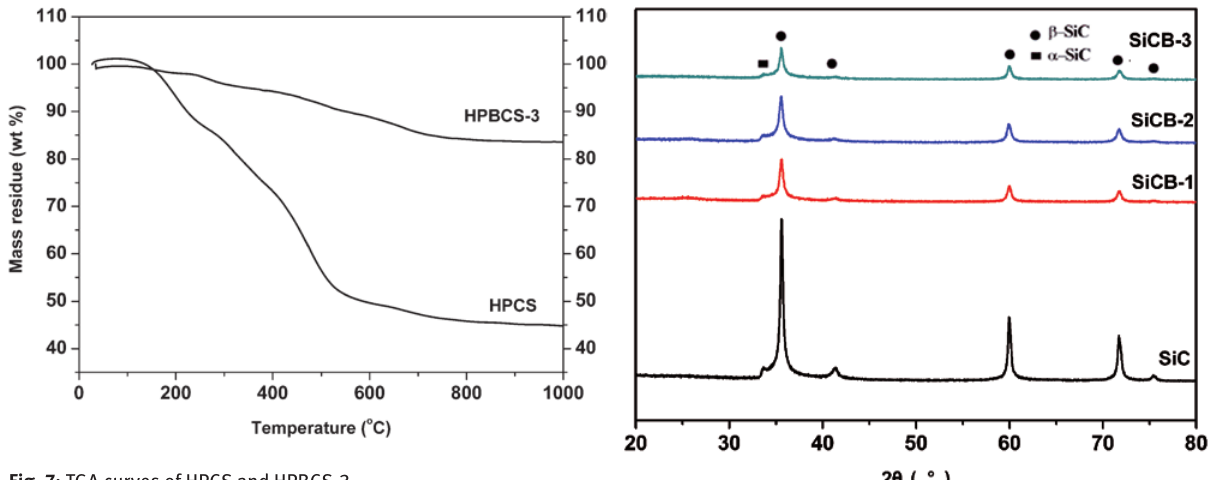
Fig. 7: TGA curves of HPCS and HPBCS-3.